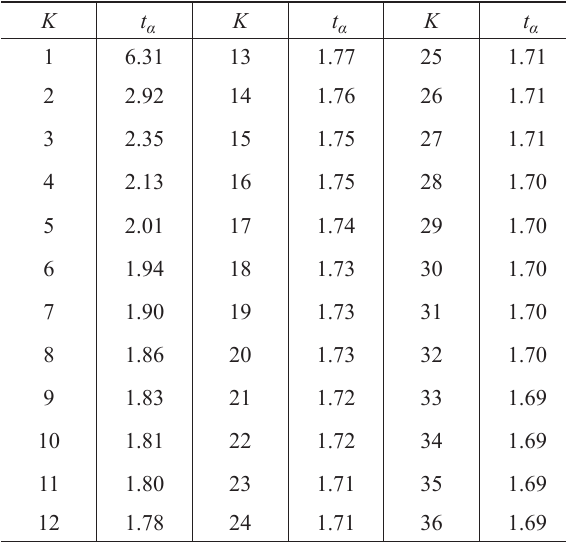
Table. 2. Magnitudes of statistical coefficient t α for α = 0.95